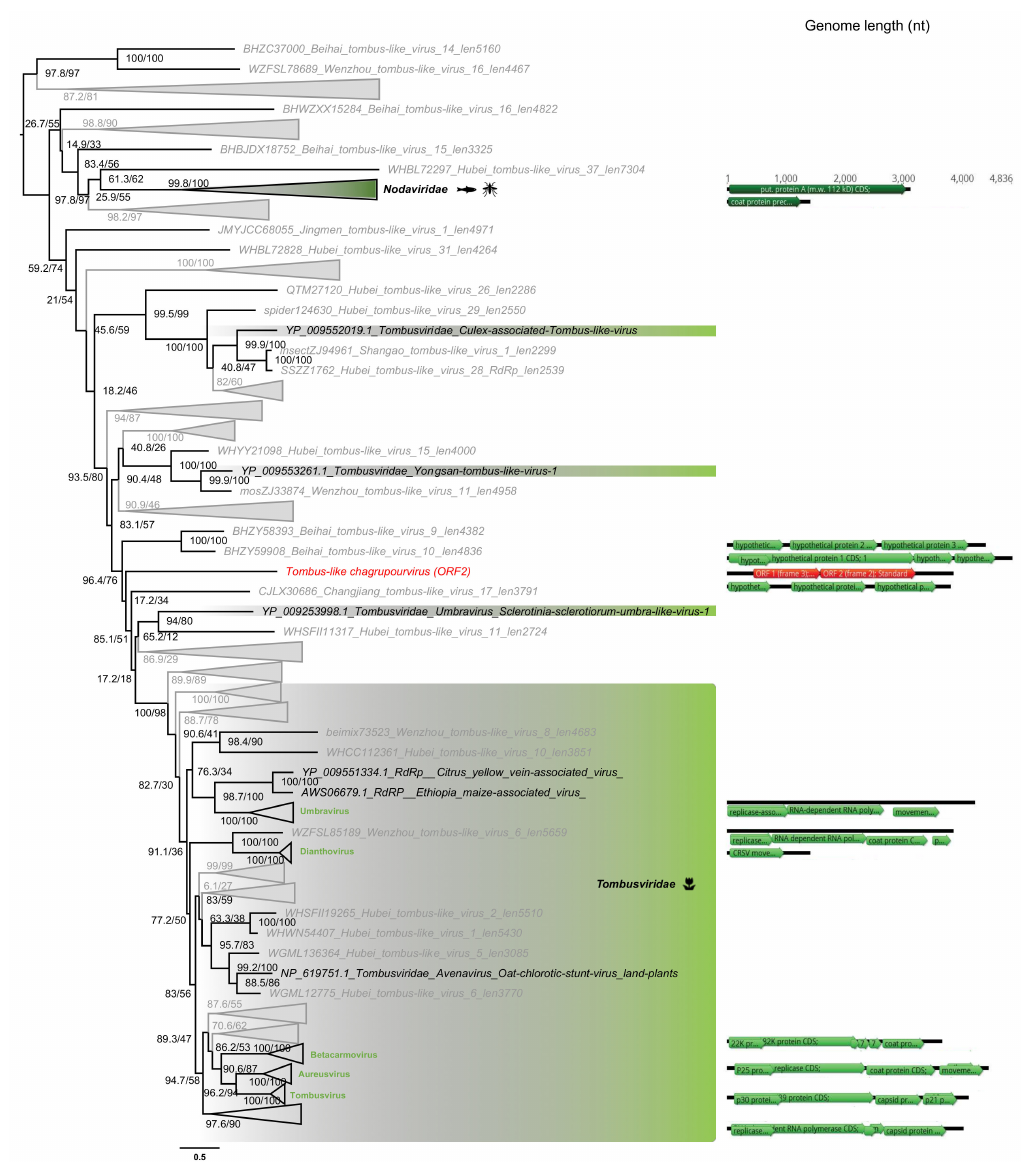
Figure 7. Phylogeny of the Tombusviridae RdRp. The tombus-like sequence identified in this study is labeled in red. Unclassified sequences from [65] are highlighted in grey. For clarity, some families and genera have been collapsed. Left, phylogenetic tree estimated using IQ-Tree with bootstrap replicates and SH-aLTR set to 1000 (values in parenthesis). Right, genomic organizations of the new viruses as well as their closest homologs and representative species from each family / genus as follows: Black beetle virus ( Nodaviridae ); Carrot mottle virus ( Dianthovirus ); Carnation ringspot virus (Dianthovirus); Beet black scorch virus ( Betanecrovirus ); Cucumber leaf spot virus ( Aureusvirus ); Maize necrotic streak virus ( Tombusvirus ); Carnation mottle virus ( Alphacarmovirus ). The tree is mid-pointed rooted and branch lengths are scaled according to the number of amino acid substitutions per